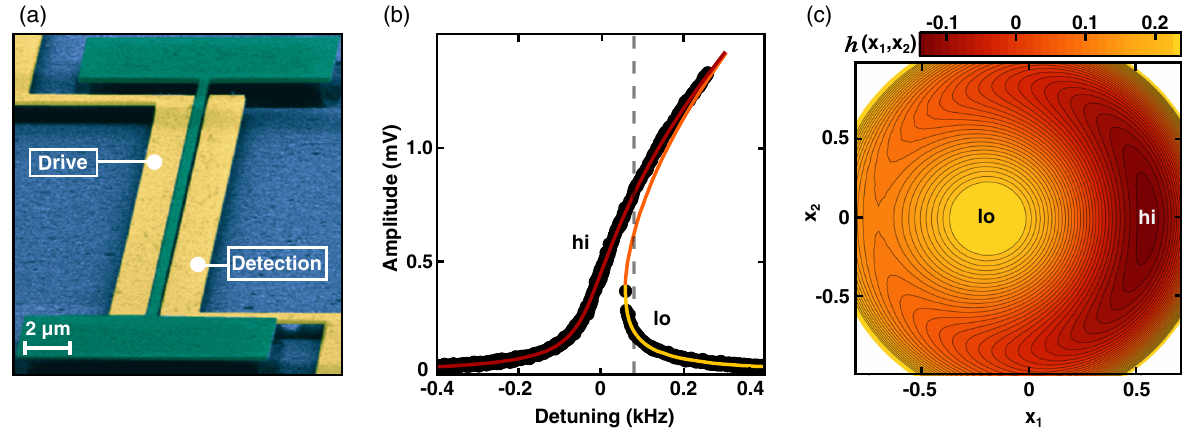
FIG. 1. (a) Scanning electron micrograph of the doubly clamped silicon nitride string resonator (green) and two adjacent gold electrodes (yellow) for dielectric control. Schematic of electronic setup is detailed in the SM [45]. (b) Duffing response curve for an external drive of − 31 dBm (black dots) and fit of the Duffing model [Eq. (1)]. The red (yellow) line denotes the high (low) amplitude solution marked “ hi ” ( “ lo ” ), while the orange line represents the unstable solution. Dashed gray line indicates the theoretically calculated critical switching point. (c) Phase space representation of the effective Hamiltonian function h ð x 1 ; x 2 Þ . Indicated are the high- ( “ hi, ” red) and low- ( “ lo, ” yellow) amplitude solution. The Hamiltonian function h ð x 1 ; x 2 Þ scaled by 8 ω F δω 2 = ð 3 γ Þ is plotted using the parameter ffiffiffi ffiffiffiffiffiffiffiffiffiffiffiffiffiffiffiffiffiffiffiffiffiffiffiffiffi